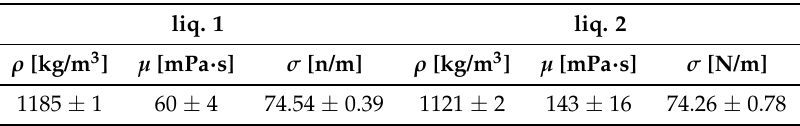
Table 1. Physical properties of the liquids.